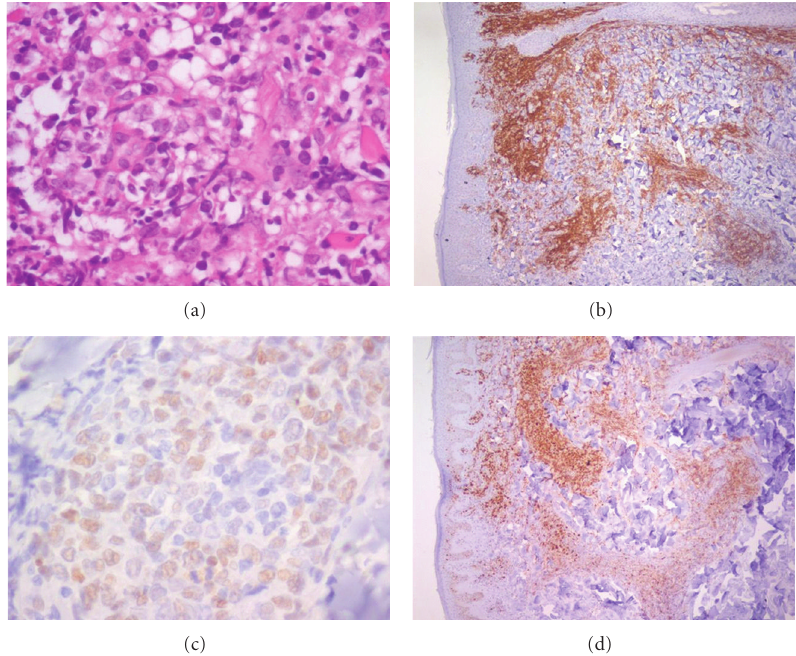
Figure 5: Skin biopsy 2006: (a) H&EX40 (Olympus BX40)—Primary cutaneous follicle center lymphoma, (b) antibody staining CD 20+, (c) antibody staining BCL6+, (d) antibody staining Ki67+